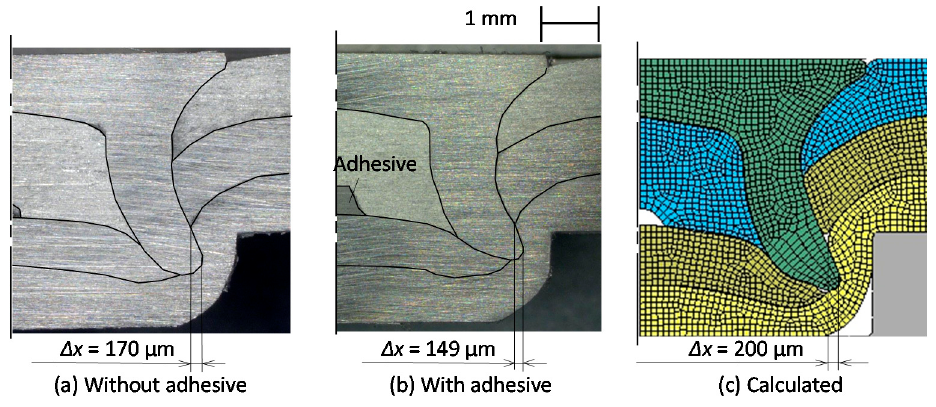
Figure 7. Cross-sectional shapes of the rivet and sheets obtained from experiment and calculation for D = 8 mm, H = 1.8 mm and L = 5 mm: ( a ) without adhesive; ( b ) with adhesive; ( c ) calculated.